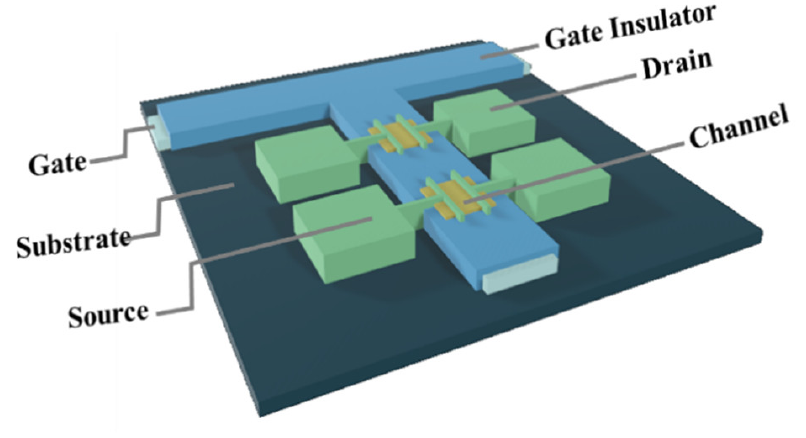
Figure 1. Schematic structure of the TFTs with an anodized gate dielectric.